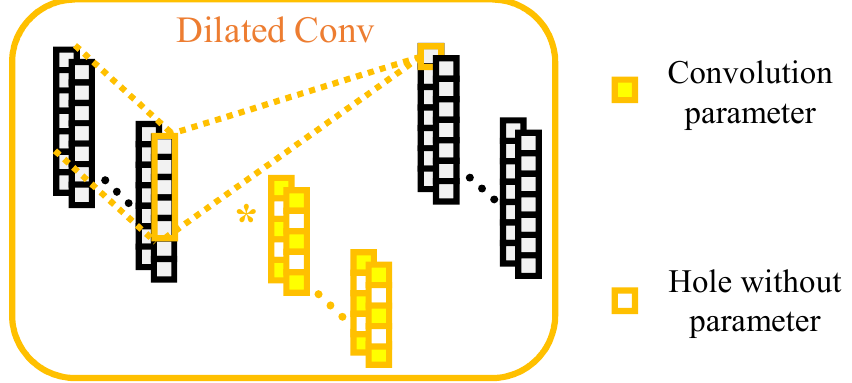
Figure 7. Realization of dilated convolution.